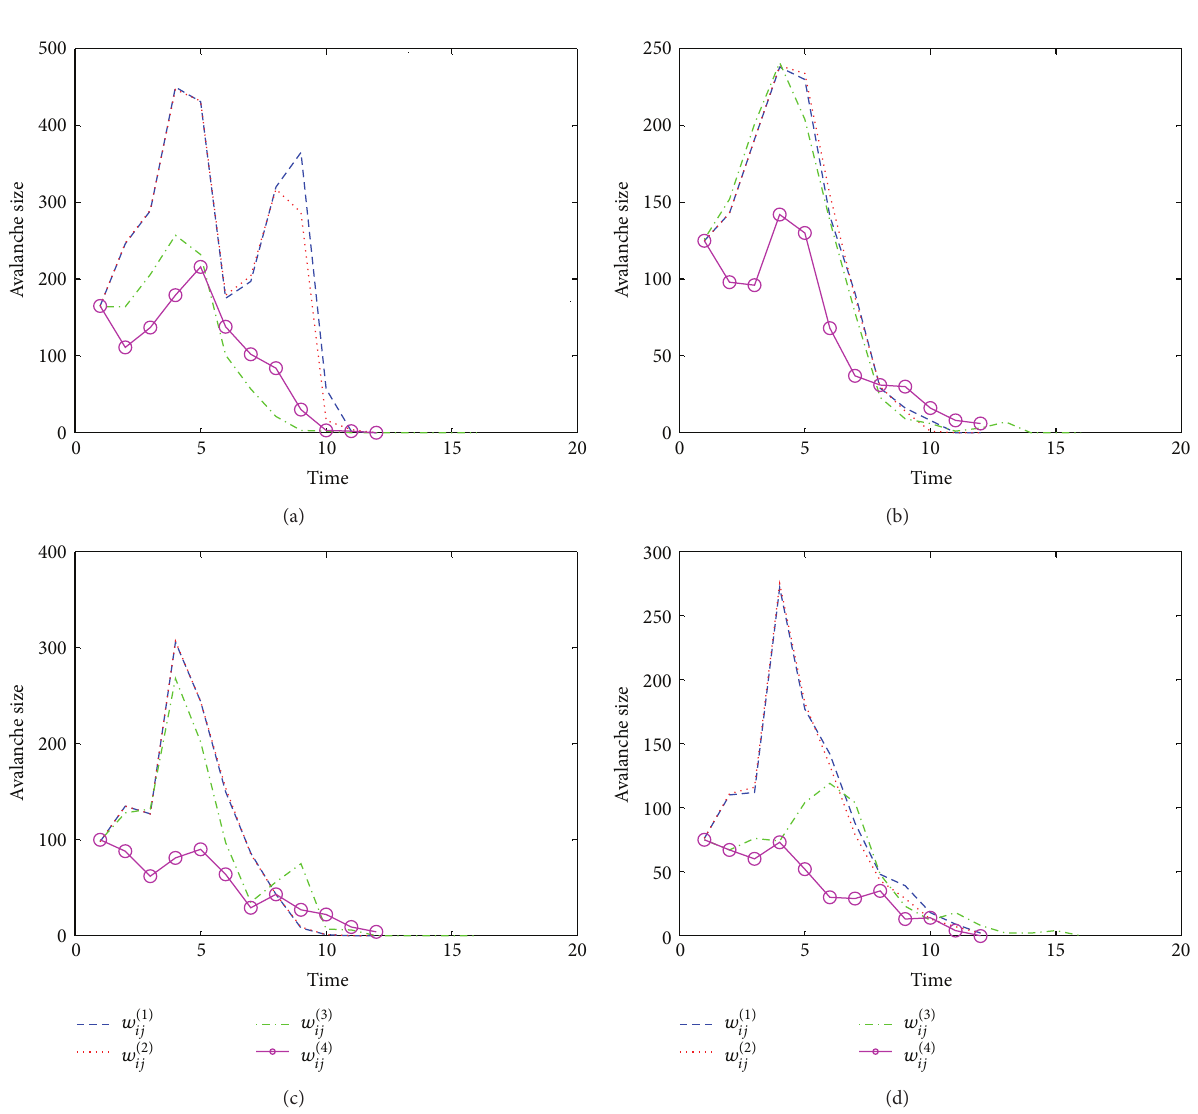
Figure 7: For SF network with 𝜏 = 100 under HL attack, the avalanche size 𝑁 𝛼 = 0.04 , (c) 𝛼 = 0.06 , and (d) 𝛼 = 0.08 ,